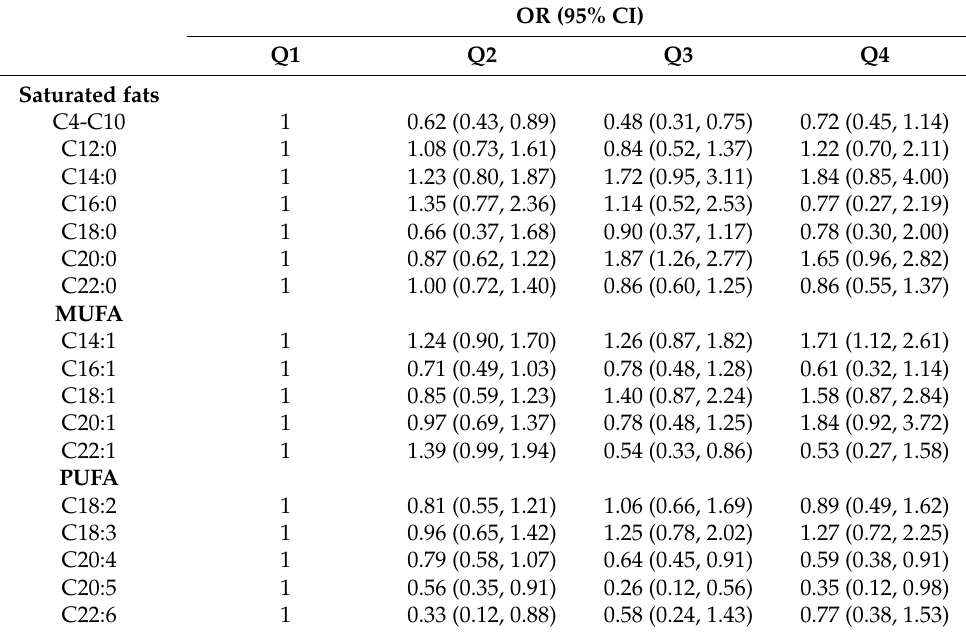
Table 3. Association between specific fats and depressive symptoms in the study sample ( n =